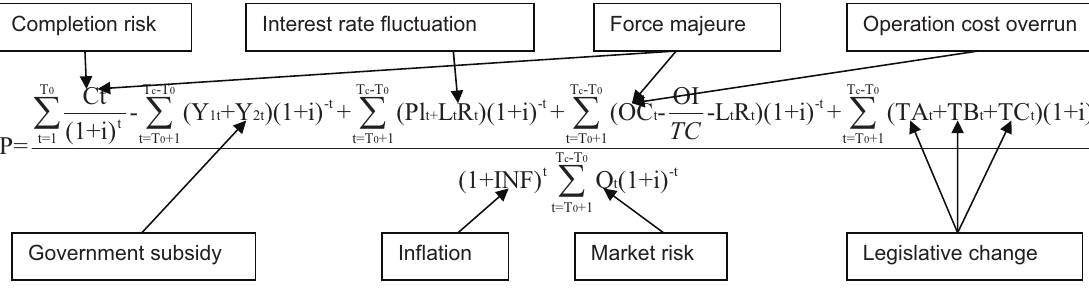
The determination of actual change range of risk variables can be classified into two